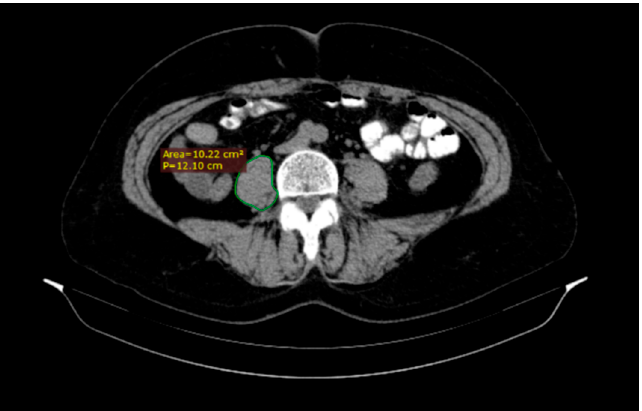
Figure 1. A quick tracing of the right (R) psoas muscle at the third lumbar vertebra (L3) level using DICOM Viewer software which automatically generates the area.